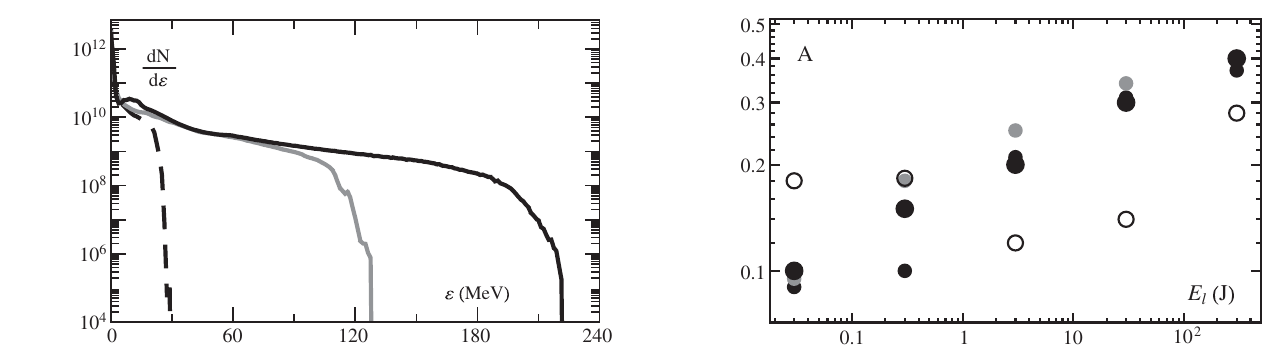
FIG. 4. Laser light absorption in the targets of optimum thickness as a function of the laser energy. Definitions of the dots are the same as in Fig.